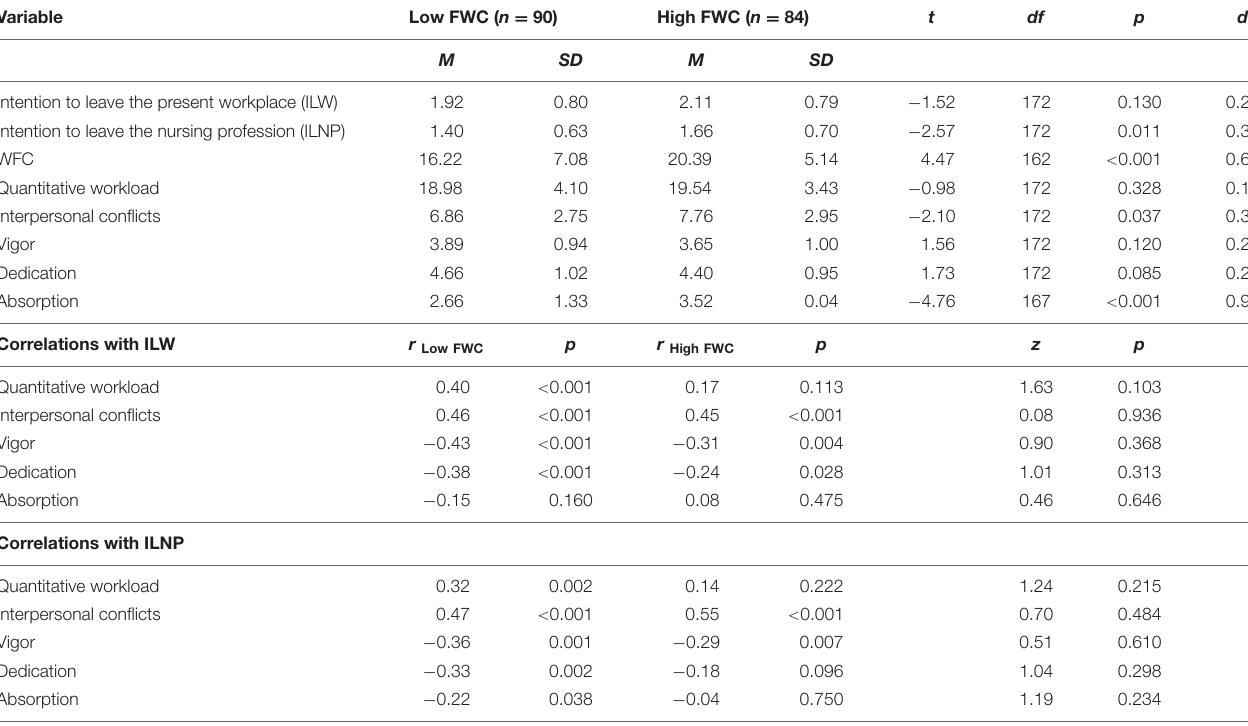
TABLE 6 | Comparisons between nurses with low and high values of family work conflict.